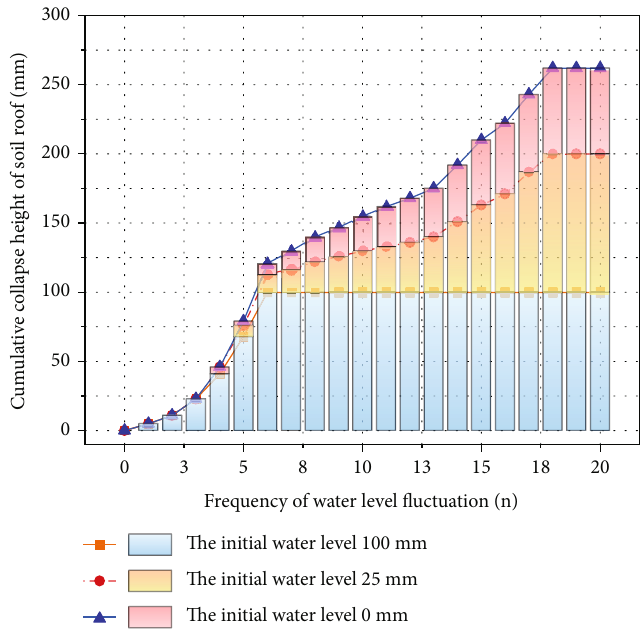
Figure 9: The relationship between the frequency of water level fl uctuation and the cumulative